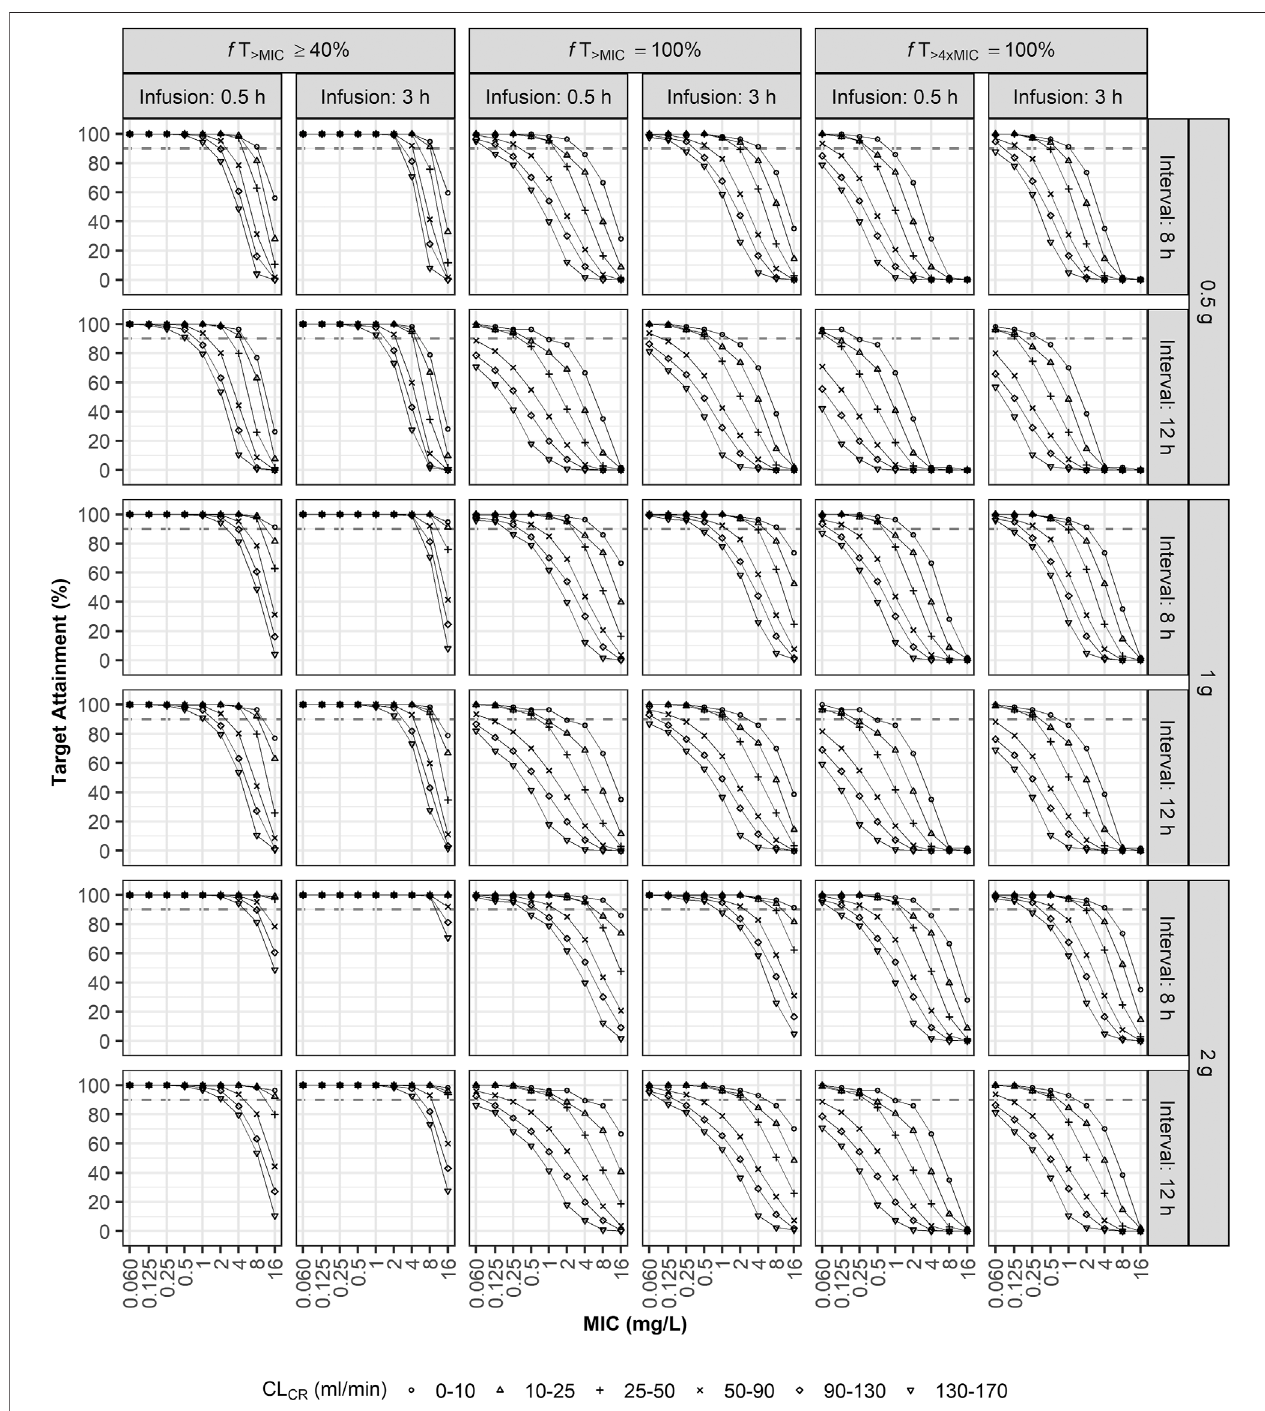
FIGURE4| Probabilitiesoftargetattainment(40% f T > MIC,100% f T > MIC,and100% f T > 4xMIC ).MonteCarlosimulationresultsforvirtualECMOpatientswhenusing combinations of three doses (0.5, 1, or 2 g), two infusion times (0.5 or 3 h), two dosing intervals (8 or 12 h), and various MICs and degrees of renal impairment as model